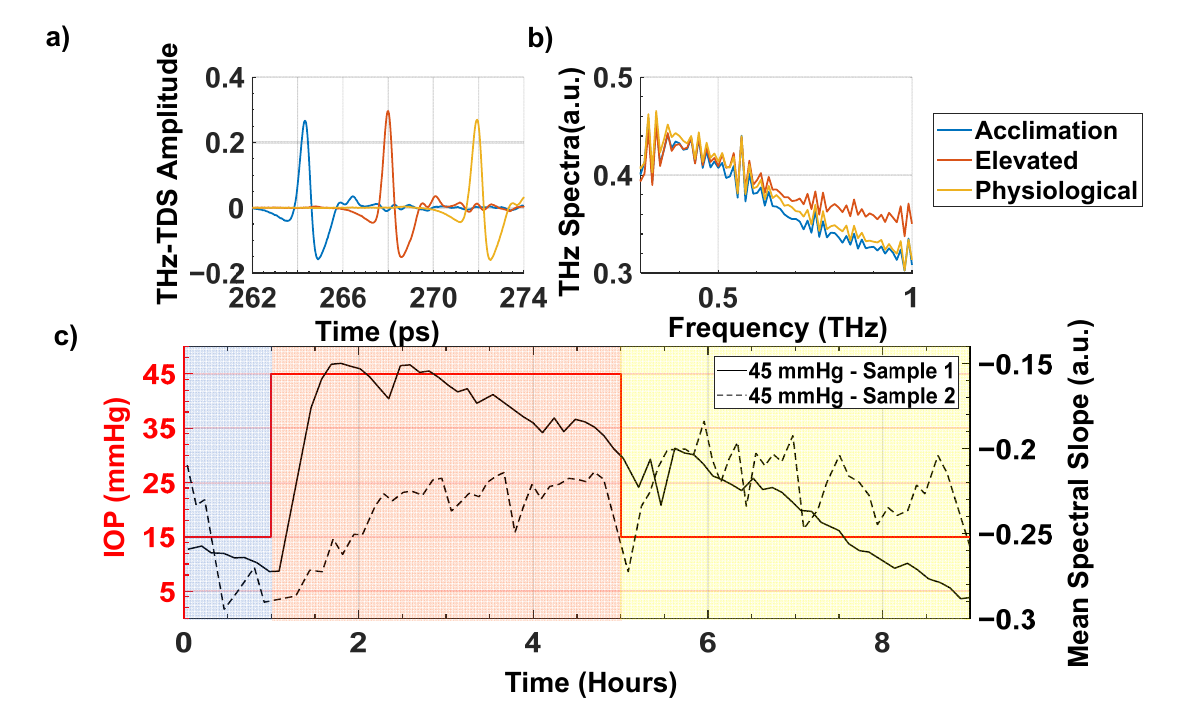
Figure 4. ( a ) The high-pass-filtered THz time–domain signals from Sample #1, at the conclusion of the acclimation period (blue), the elevated period of 45 mmHg (orange) and return to physiological period of 15 mmHg (yellow). ( b ) The deconvolved THz spectra of the same Sample #1. ( c ) The mean spectral slope between 0.4 and 1 THz, averaged over the central 25 pixels, obtained from two different samples, whose IOP were both elevated to 45 mmHg for 4 h. The changes in the intraocular pressure are shown in red color and the left y-axis of the plot.